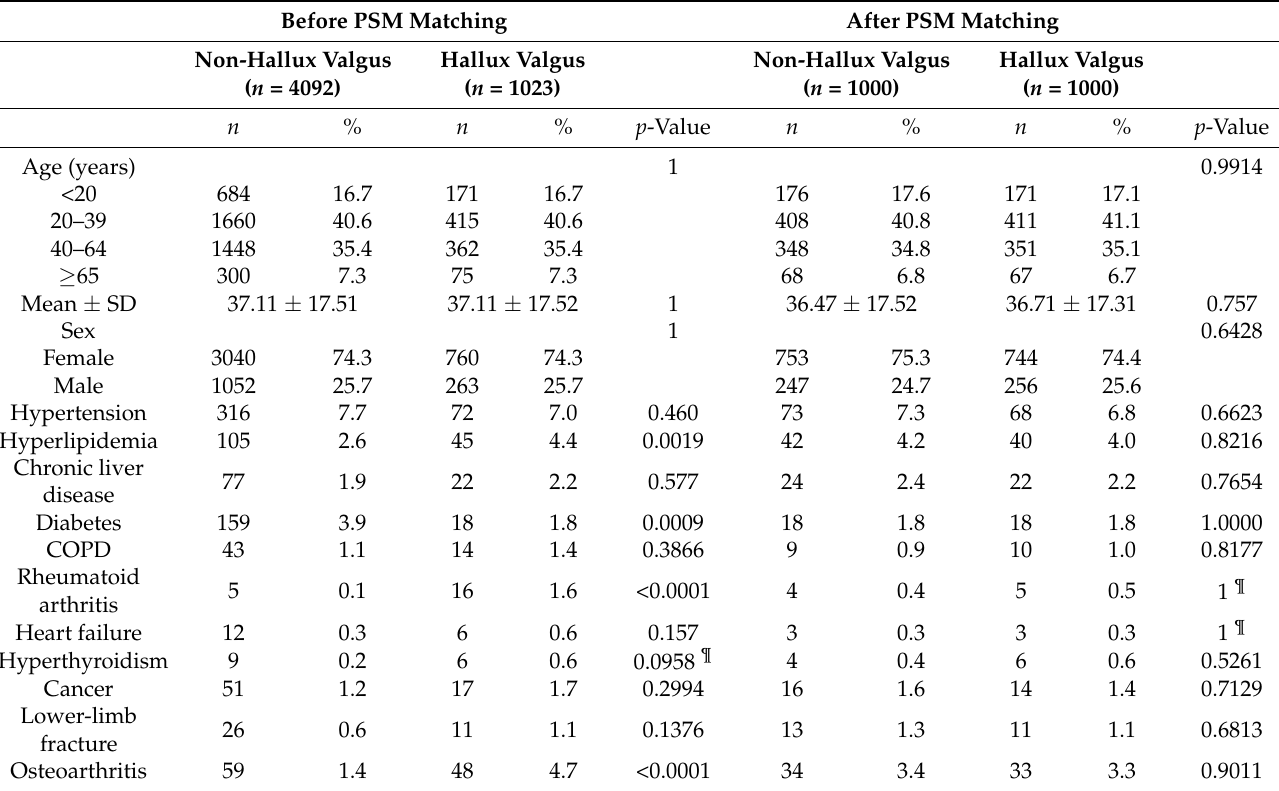
Table 1. Demographic characteristics of the hallux valgus and non-hallux valgus groups.